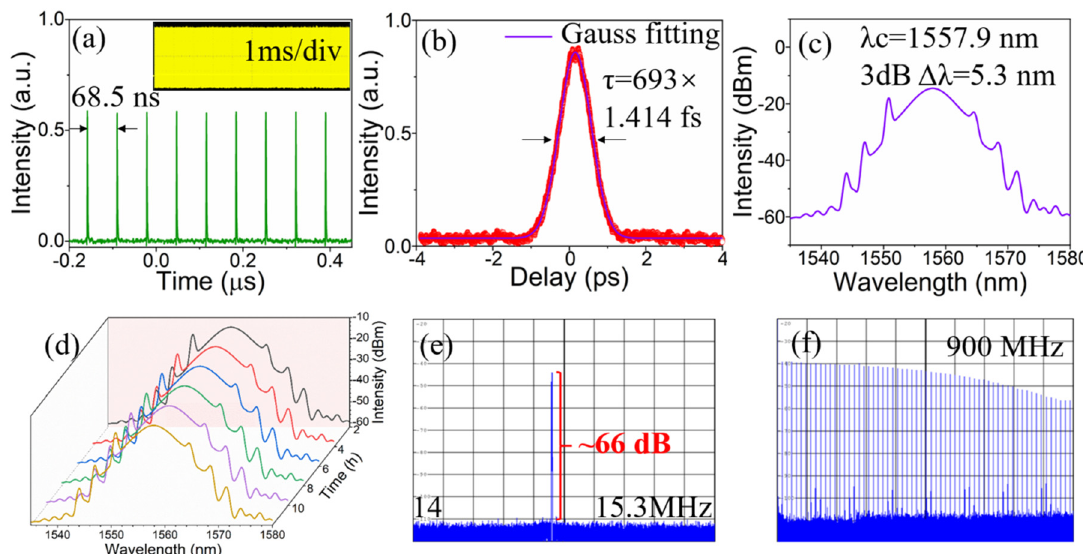
Figure 6: Output characteristic of the S-C 3 N 4 based mode-locked EDFL. (a) Pulse train with different scale. (b) Autocorrelation trace. (c) Emission spectrum. (d) Evolution of the spectrum in 12 h. (e) RF fundamental frequency spectrum. (f) RF spectrum within 900 MHz.